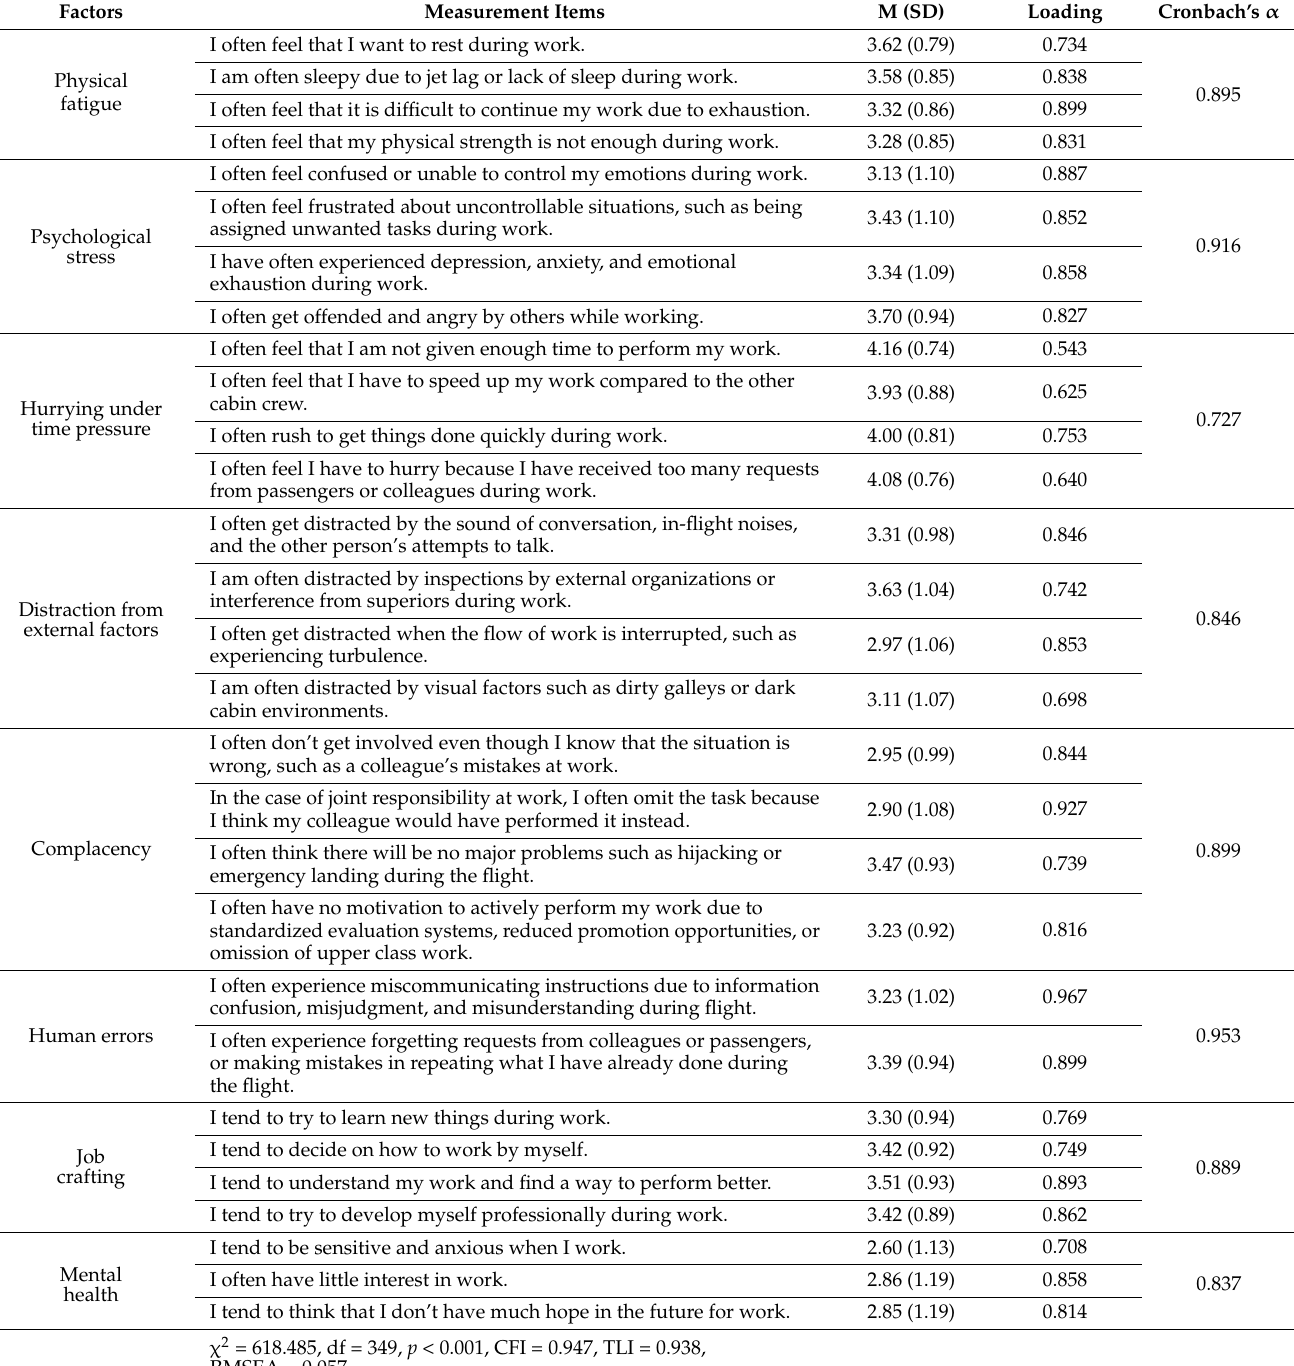
Table 2. Results of CFA and Reliability